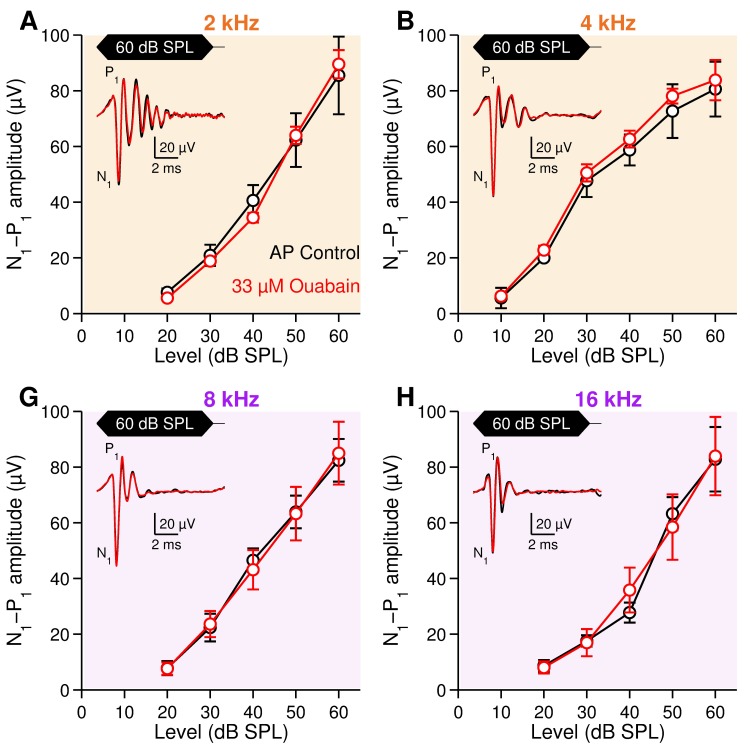
Compound action potential of the auditory nerve in control and ouabain-poisoned cochleae.CAP amplitude-intensity functions in response to 2 (A), 4 (B), 8 (G), and 16 kHz (H) tone bursts, in artificial perilymph control (black, n = 10) and ouabain-poisoned cochleae (red, n = 9). Inset: Example of CAP in control (black) and ouabain-poisoned cochleae (red). CAP amplitude was measured between N1 (the first negative wave) and P1 (the subsequent positive wave). Data are mean ± SEM. No statistical difference was found between control and ouabain-perfused animals. p > 0.05, two-way ANOVA.